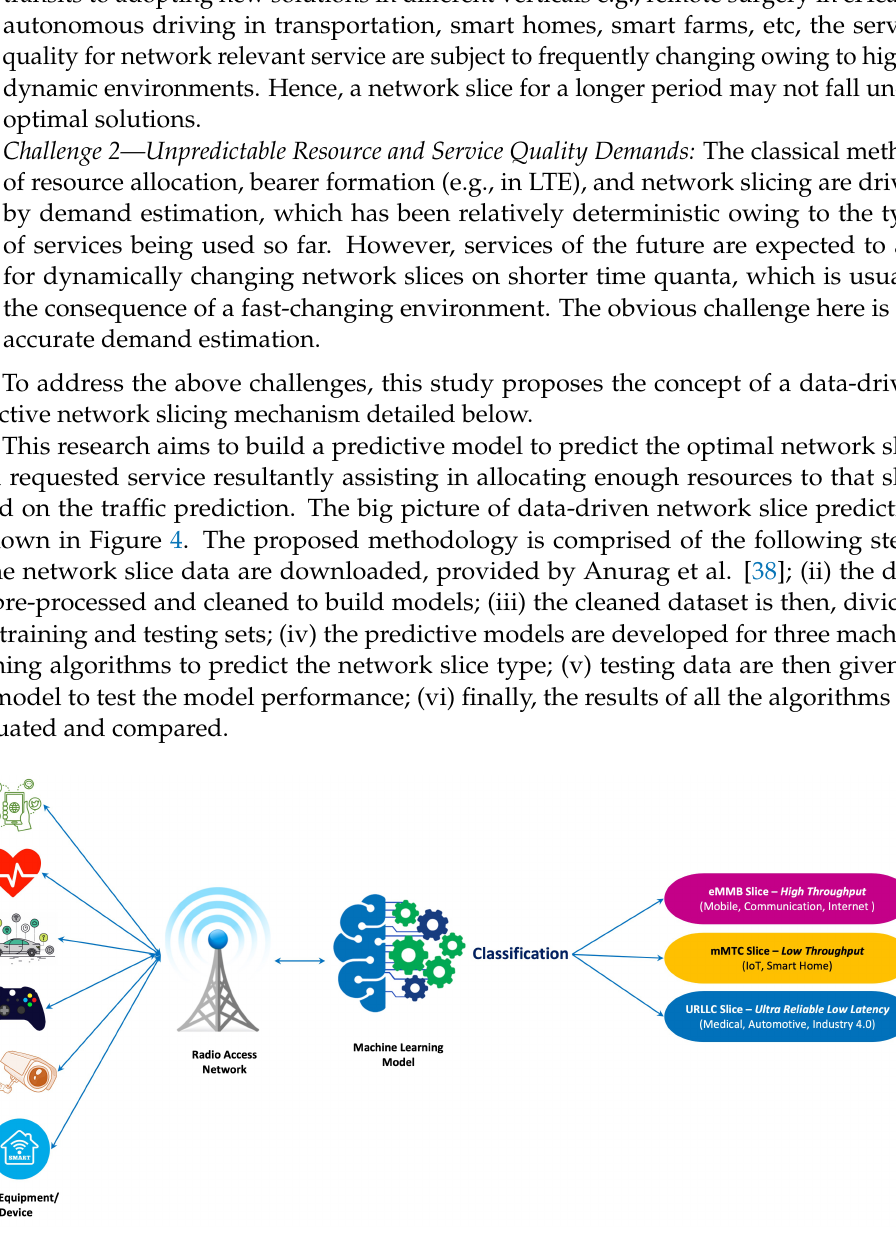
Figure 4. Big picture of Data-Driven Network Slice